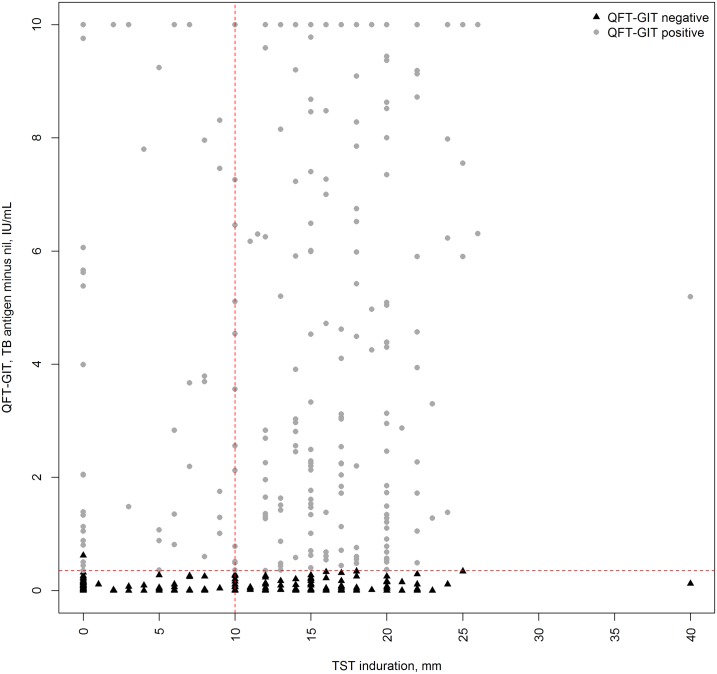
Scatterplot of quantitative QuantiFERON-TB Gold In-Tube (QFT-GIT) and tuberculin skin test (TST) results of 631 healthcare workers.The horizontal red dashed line represents a QFT-GIT cut-off of 0.35 IU/mL and the vertical one a TST cut-off of 10 mm. Samples with a QFT-GIT TB Antigen value inferior to the nil value were truncated to 0 (n = 122) and samples with a QFT-GIT TB Antigen value > 10 IU/mL were truncated to 10 (n = 63). One sample had a QFT-GIT TB Antigen minus nil value superior to 0.35 IU/mL but inferior to 25% of the nil value leading to a negative test result.